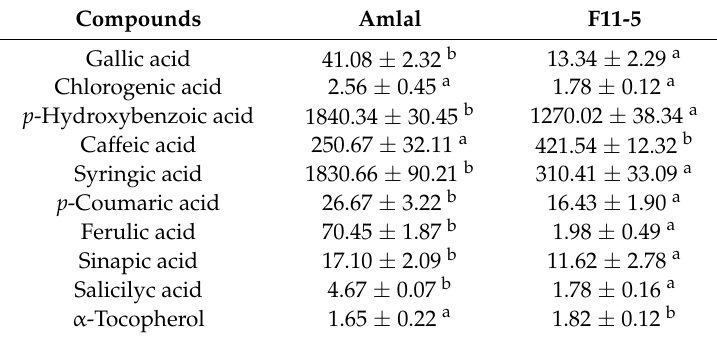
Table 1. Phenolic and tocopherol composition of hybrid Oat and parent in mg/Kg. Compounds